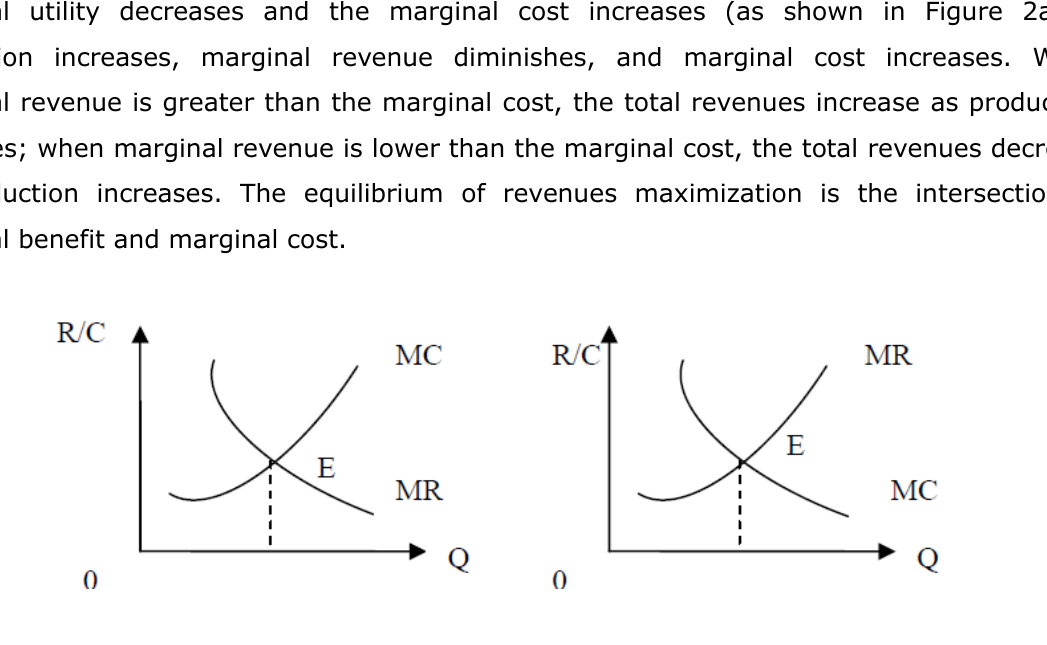
Figure 2. The traditional market equilibrium and the positive feedback of software market. (a) The traditional market equilibrium (b) The positive feedback of software